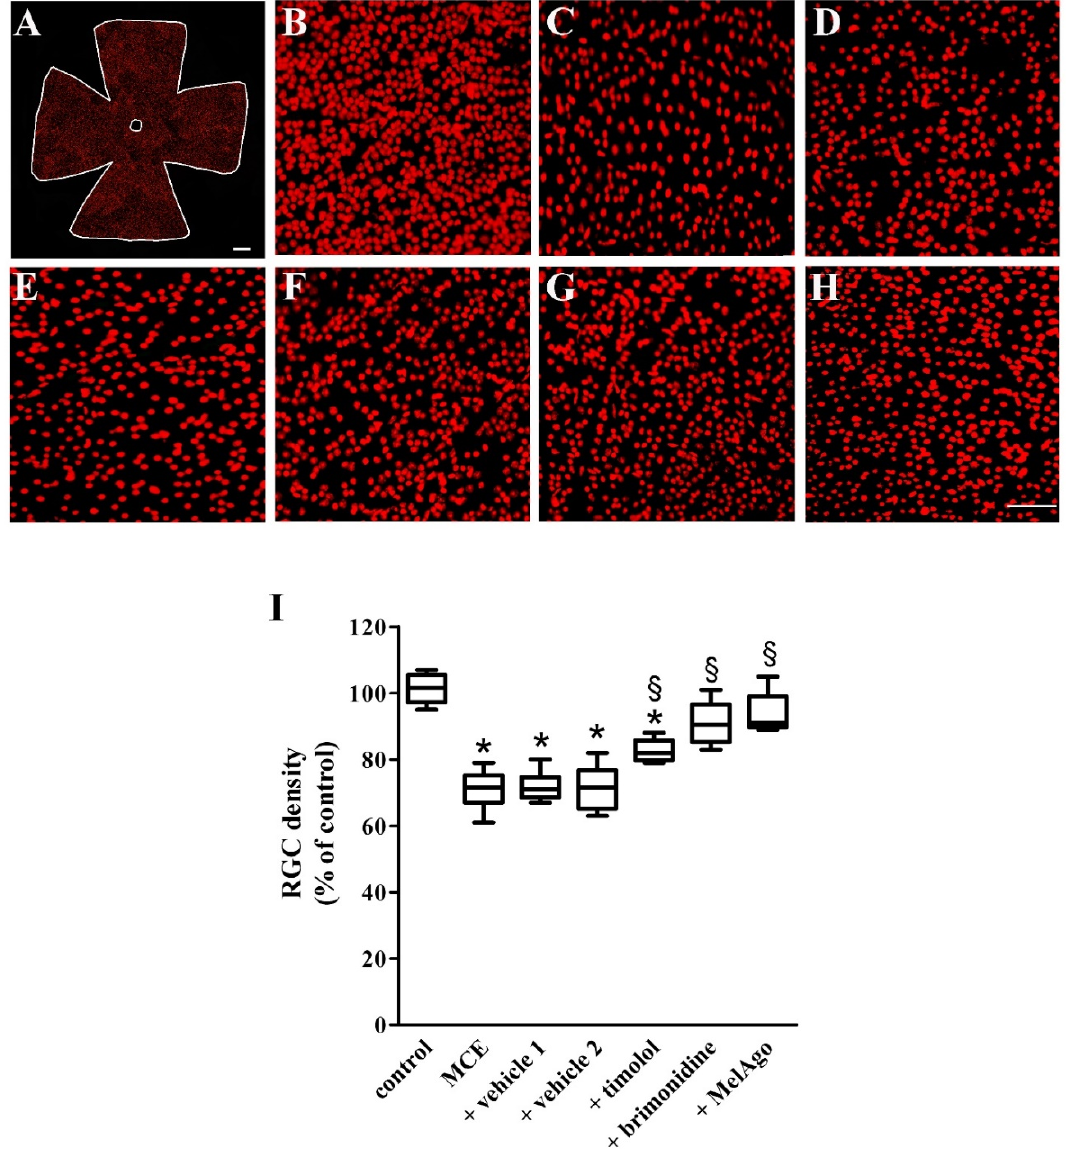
Figure 7. Retinal ganglion cell (RGC) density. ( A ) Representative image of a control flat-mount immunostained for the brain-specific homeobox / POU domain protein 3A (Brn3a). ( B – H ) Representative high magnification images from the middle retina (sampling location at about 2.5 mm from the optic disc) from control rats ( B ) or rats that received MCE either untreated ( C ) or treated with vehicles ( D,E